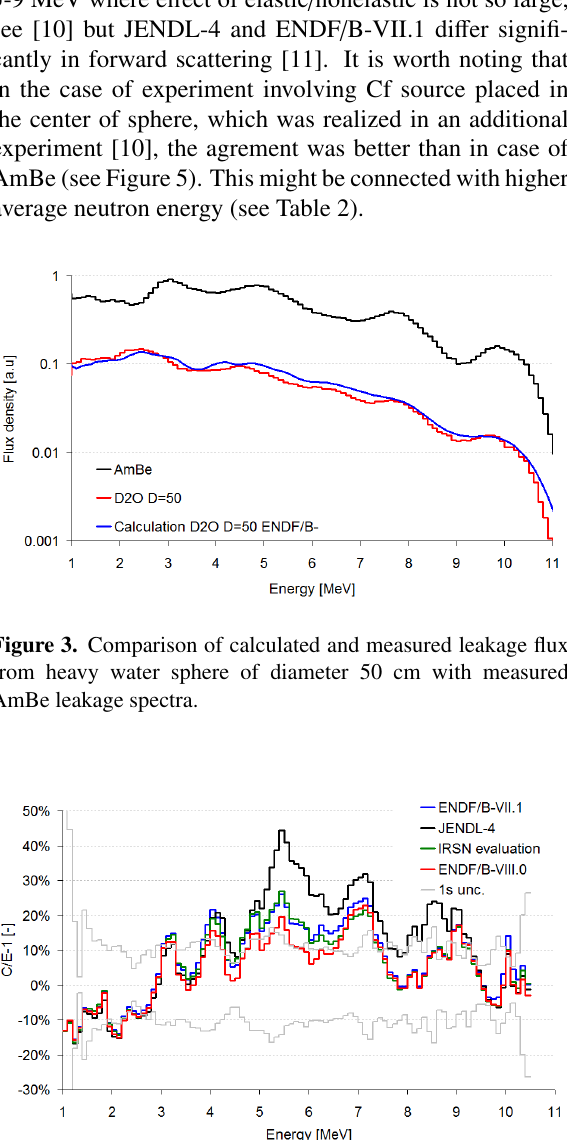
Table 1. Measured AmBe neutron leakage spectra.